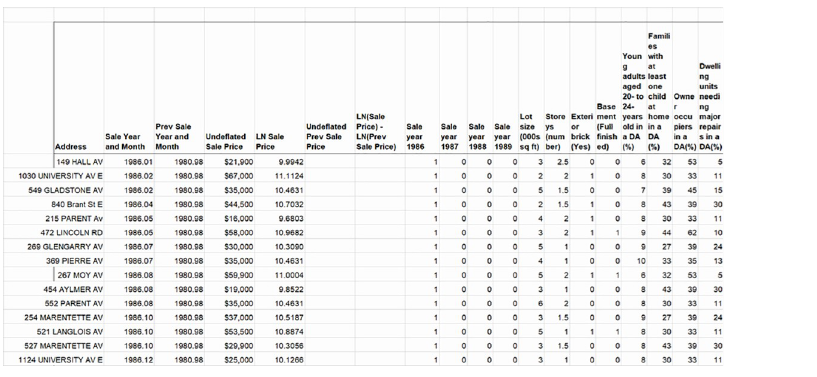
Fig 1. Selected once-sold homes and variables in the